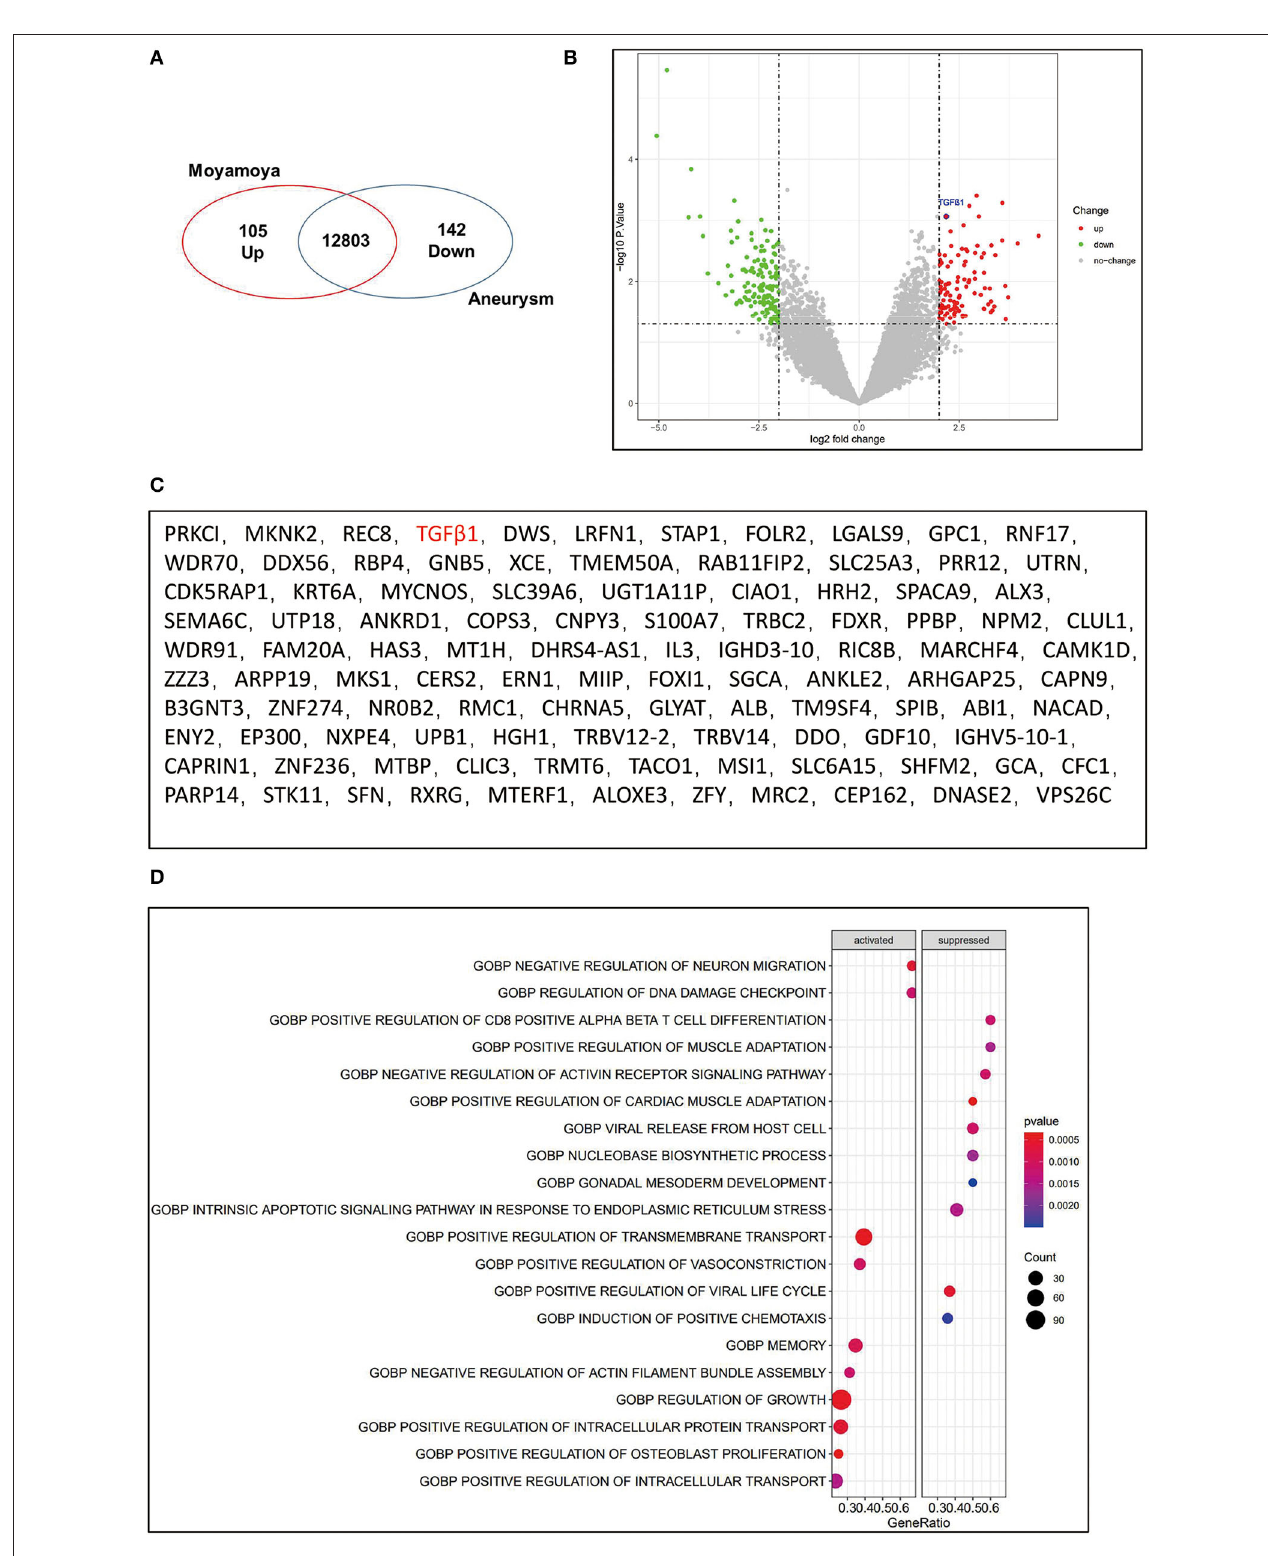
FIGURE 2 | Upregulation of TGF β 1 in the middle cerebral artery(MCA) of MMD. (A) Venn diagram showed significantly upregulated genes ( n = 105) and significantly downregulated genes ( n = 142). (B) Volcano plot to visualize the DEGs in MMD compared to control. The significantly upregulated genes were shown with red dots, and green dots represent significantly downregulated genes. Gray dots represent genes not differentially expressed. (C) the upregulated genes were listed. (D) GO functional enrichment analysis of sequencing data.